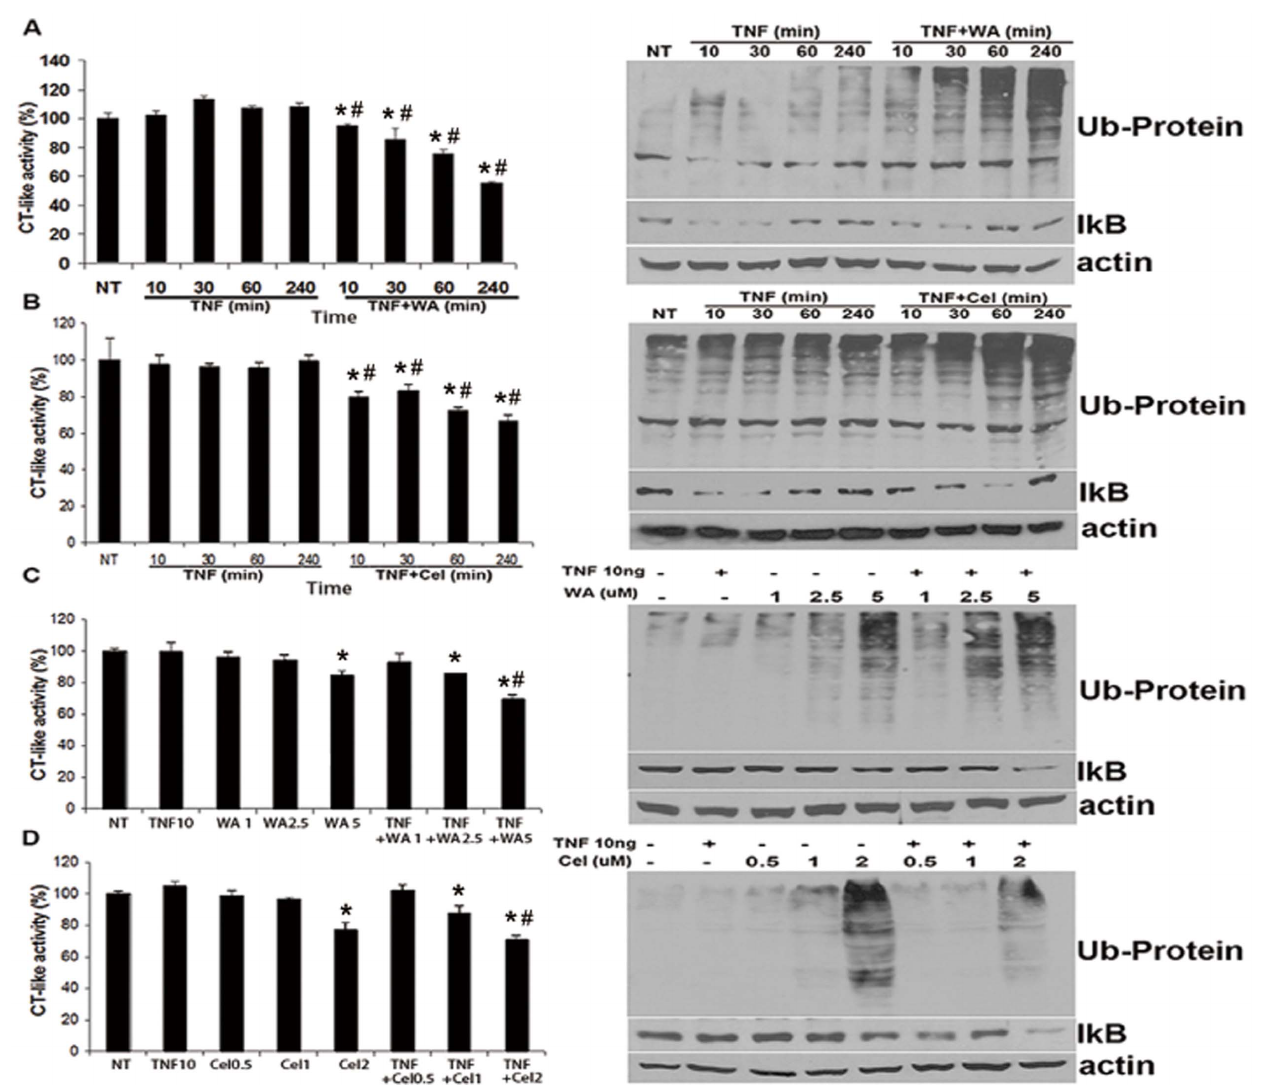
Figure 4. Kinetic and dose effects of TNF plus WA/Cel on cellular proteasome activity in MDA-MB-231 cells. Cells were treated with TNF- a (10 ng/ml) or TNF- a (10 ng/ml) plus WA or Cel for the indicated times and doses, followed by measurement of the proteasomal CT-like activity using Z-GGL-AMC or Western blotting for ubiquitinated proteins and I k B a . (A) Kinetic effects of TNF- a plus WA on CT-like activity, ubiquitinated proteins and I k B a . Cells were treated with WA (2.5 m M) with or without TNF- a for the indicated times. (B) Kinetic effects of TNF- a plus Cel on CT-like activity, ubiquitinated proteins and I k B a . Cells were treated with Cel (1 m M) with or without TNF- a for the indicated times. (C) Dose effects of TNF- a plus WA on proteasomal activity, ubiquitinated proteins and I k B a . Cells were treated with the indicated doses of WA with or without TNF- a for 24 hours. (D) Dose effects of TNF- a plus Cel on proteasomal activity, ubiquitinated proteins and I k B a . Cells were treated with the indicated doses Cel with or without TNF- a for 24 hours. Data are shown as mean ¡ SD of three experiments. (* P , 0.05, as compared with the untreated control. # P , 0.05, WA/Cel treated versus WA/Cel + TNF- a ).